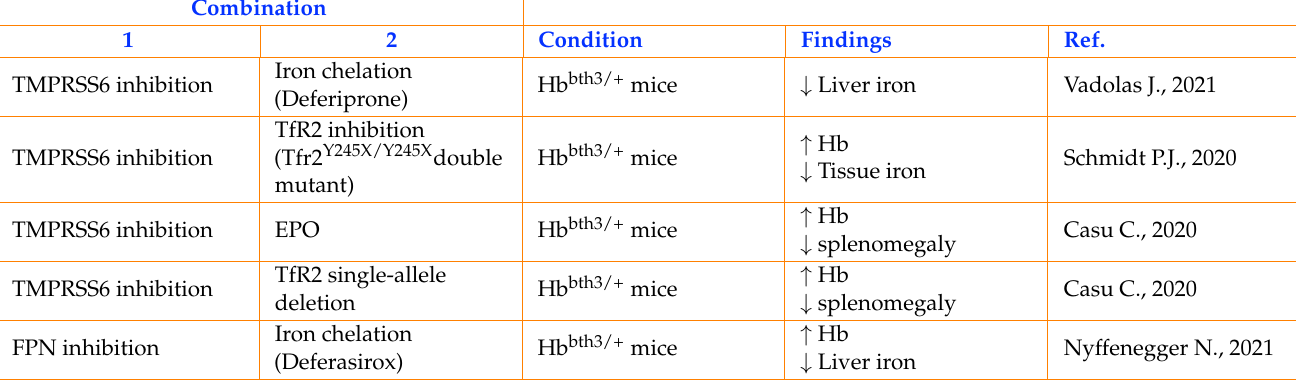
Table 2. Potential combination of treatments targeting hepcidin function (TD =